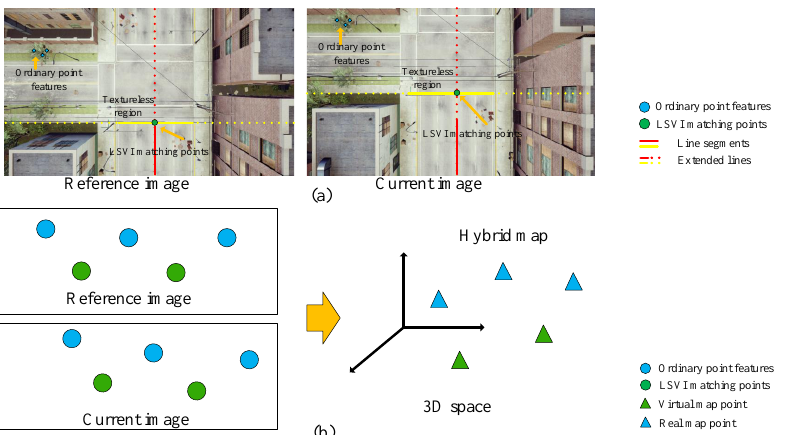
Figure 1. ( a ) The distribution of the LSVI matching points and ordinary point features. The solid lines represent the line segments, the dashed lines represent the corresponding extended lines. The blue and green dots denote ordinary point features and LSVI matching points, respectively. ( b ) The composition of the hybrid map built on the LSVI matching points and ordinary point features. The blue and green triangles represent real and virtual 3D map points, respectively.